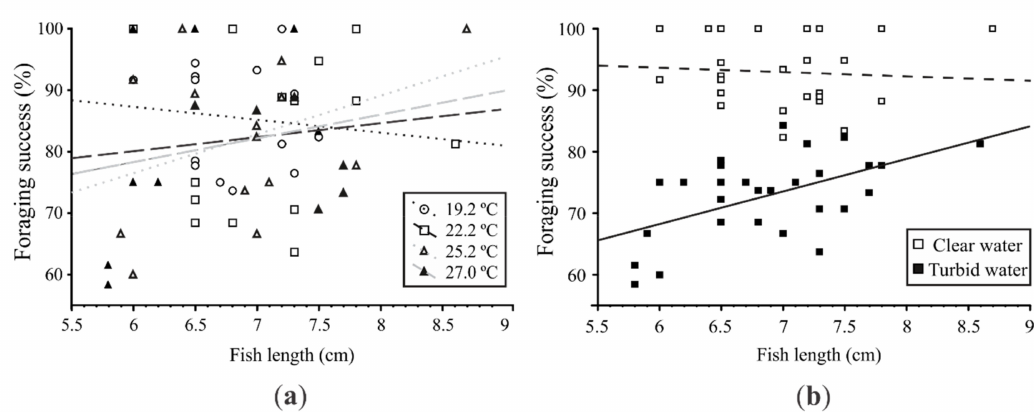
Figure 2. Relationship between the foraging success of Gymnogeophagus terrapurpura and fish length (n = 56) under di ff erent water temperature ( a ) and turbidity conditions ( b ), after pooling the data from the levels of the factor not shown in each panel. In panel ( a ), dotted black line, dashed black line, dotted grey line and dashed grey line are the observed (not significant) patterns in 19.2, 22.2, 25.2 and 27.0 ◦ C, respectively. In panel ( b ), white squares: clear water (3 NTU), black squares: turbid water (100 NTU). Full and dashed lines are the best models fitted for the observed patterns in turbid ( t = 3.292; P = 0.001; adjusted R 2 = 0.27, F 1,26 = 10.75, P = 0.002) and clear waters ( t = –0.383; P = 0.703), respectively. Table 2. E ff ects of turbidity and water temperature on the foraging success of predator Gymnogeophagus terrapurpura on amphipod Hyalella curvispina , with fish length (standard length, cm) as a continuous predictor variable (GLM results, above section). The significance of the t -test of the angular coe ffi cient (slopes derived from the relationship between foraging success and the fish length for each level of both main factors) are also presented in the section below. Statistically significant results are shown in bold. Degrees of Means of Main E ff ects Freedom